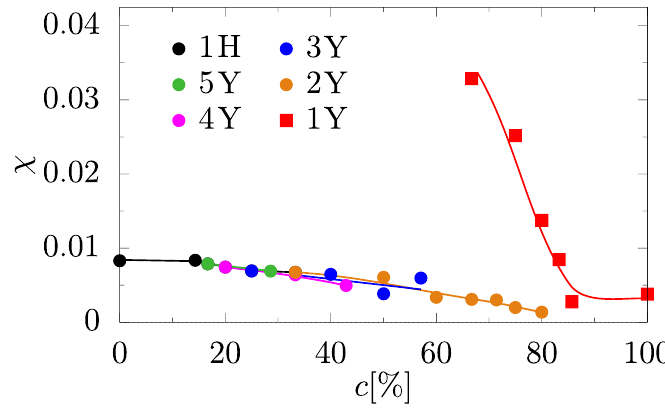
Figure 5. Degree of auxeticity as a function of concentration c . χ = 0 corresponds to the case of non-auxetic system. Lines are drawn to guide the